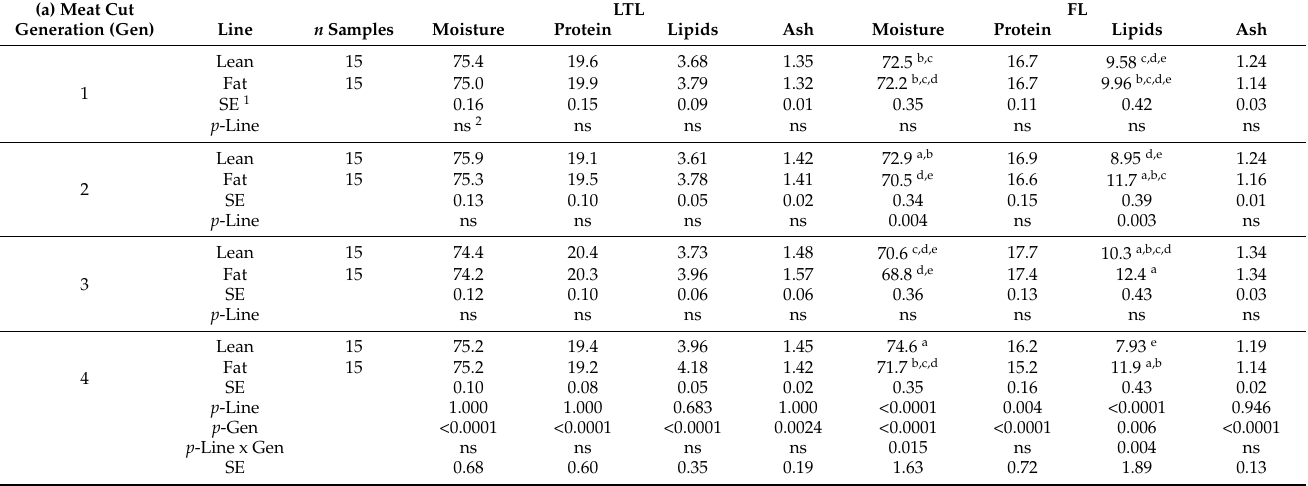
Table 1. ( a ) Proximate composition (g/100 g of meat) of the longissimus thoracis et lumborum (LTL) and forelegs (FLs) of Lean and Fat rabbits along four generations of divergent selection for total body fat content. ( b ) Proximate composition (g/100 g of meat) of the hind legs (HLs) and abdominal wall (AW) of Lean and Fat rabbits along four generations of divergent selection for total body fat content. LTL FL Generation (Gen)